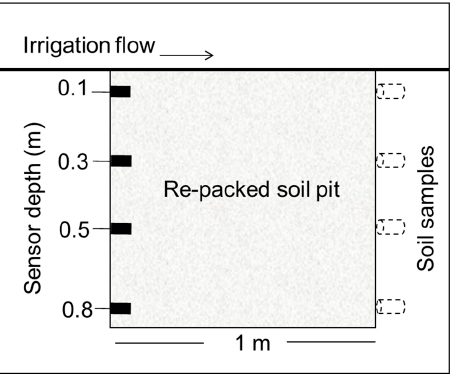
Figure 2. Schematic of soil water sensor placement and soil sampling depth at the Rio Hondo site.